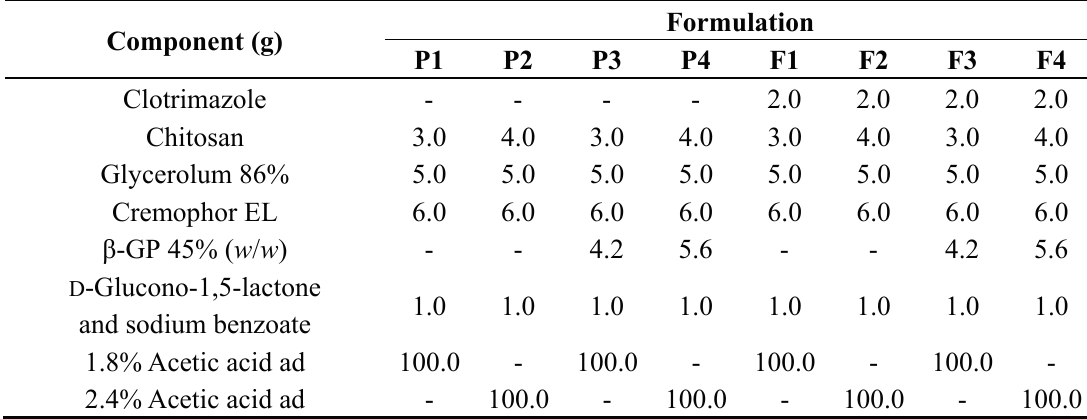
Table 2. Composition of prepared